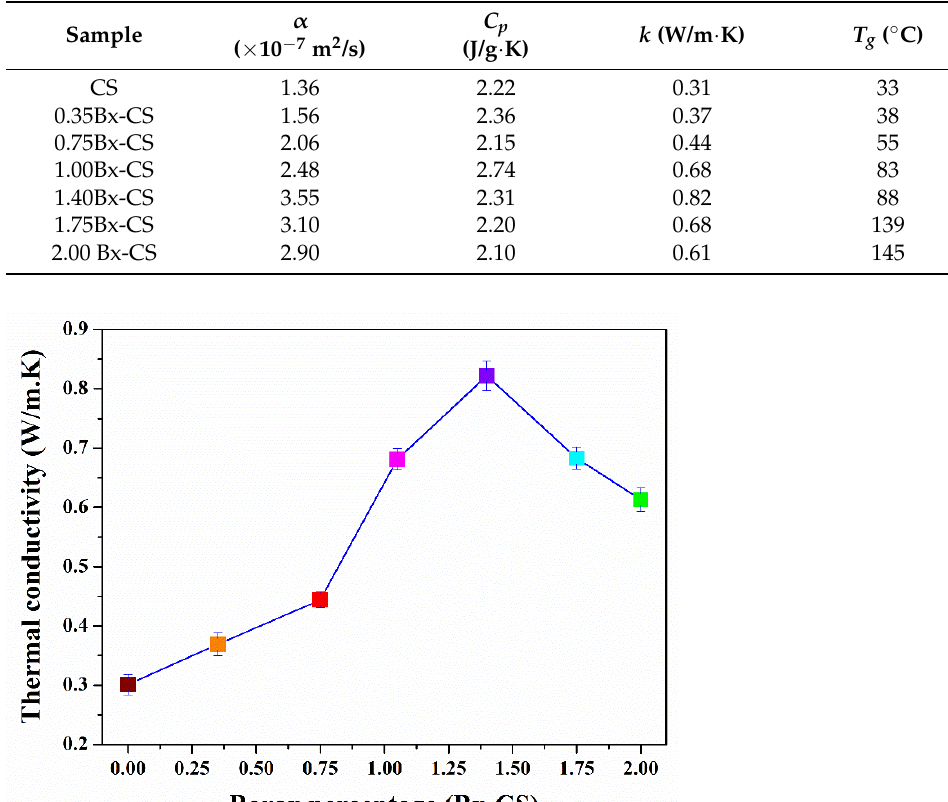
Table 1. Thermal properties of cassava starch films with different percentages of borax added.